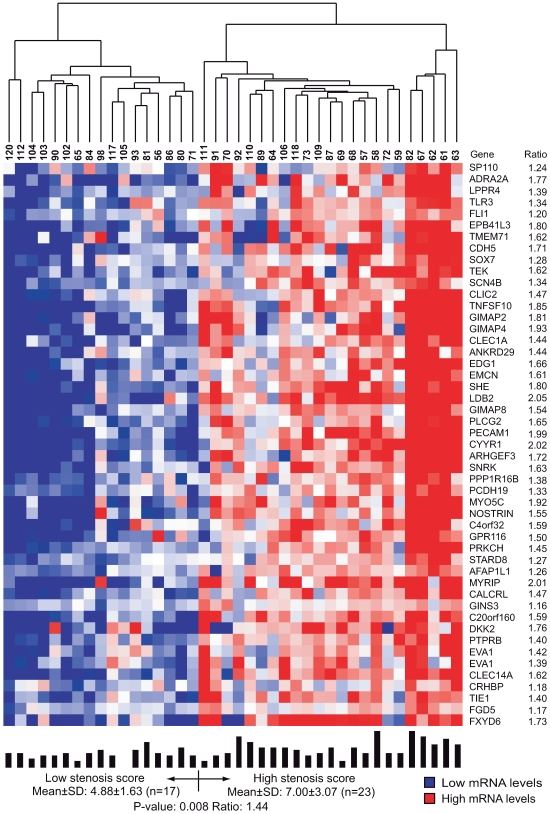
Heat map of an atherosclerotic arterial wall cluster related to coronary stenosis.The cluster was defined by related mRNA levels (indicated by average probe signals on the arrays) and identified as one of fourteen atherosclerotic arterial wall clusters by the second step of coupled two-way clustering of mRNA profiles from STAGE patients (Text S1). Columns represent individual patients, and rows individual RefSeqs with corresponding gene symbols and mRNA ratios of the two patient groups. Above heat map: individual patient numbers, below heat map: bars indicating individual stenosis score together with means ± SD and average ratios in each group and P-values for comparing groups. EVA1 is represented by two RefSeqs.